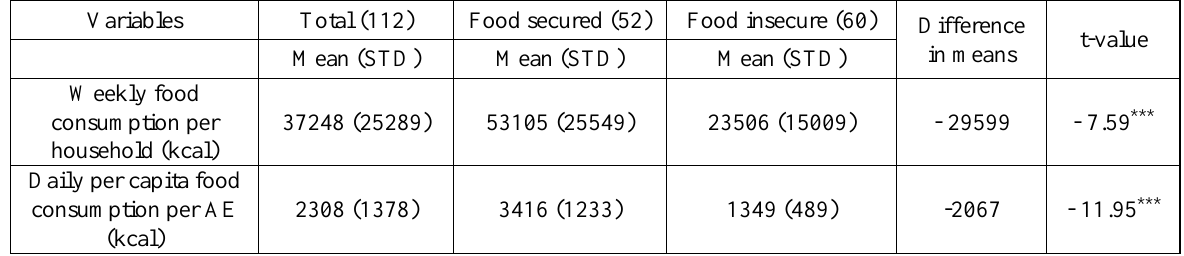
Table 5. Weekly and daily food consumption status of the sample households (in kcal) Variables